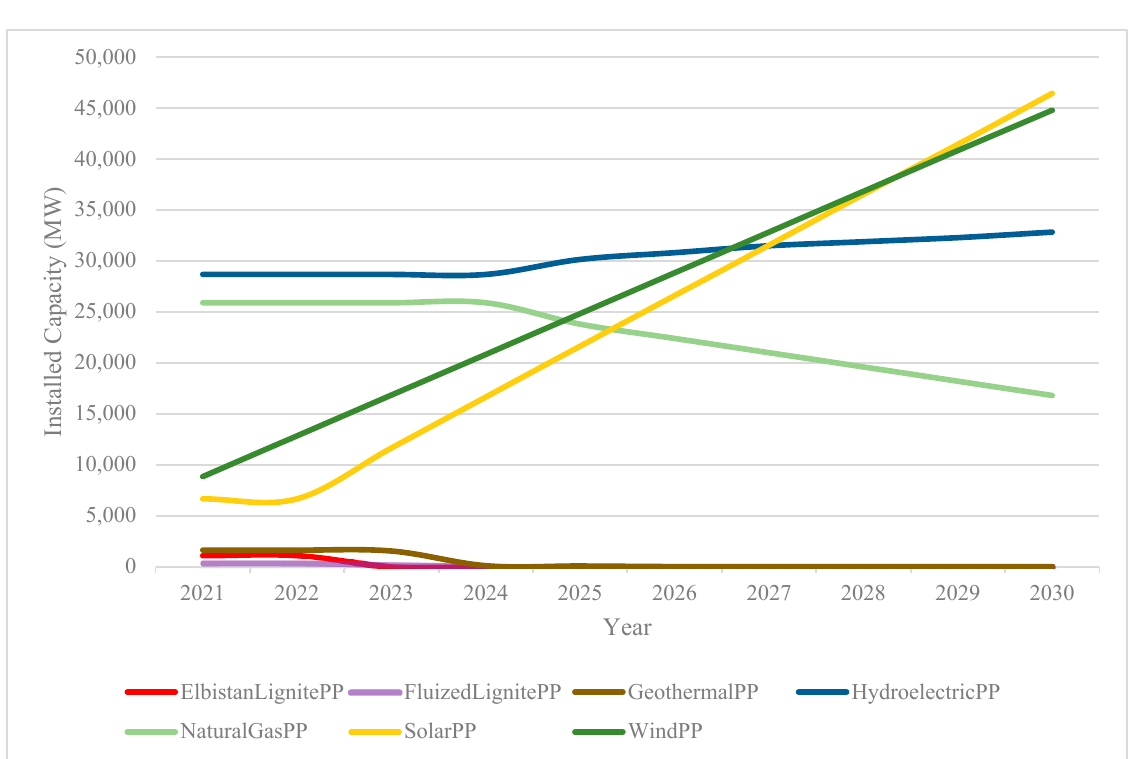
Figure 5. Installed capacities for the first scenario in the 2021–2040 horizon. The starting capacity of each power plant type was supplied in the base scenario, and the new power plant requirements were estimated based on this initial capacity. In the second scenario, we want to explore what happens when the model determines all power plant types and their capacities. Furthermore, as in the first scenario, it is anticipated that